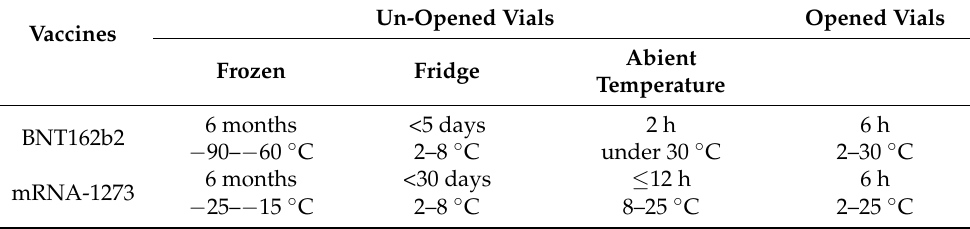
Table 3. Stability and storage requirement of BNT162b2 and mRNA-1273 vaccines